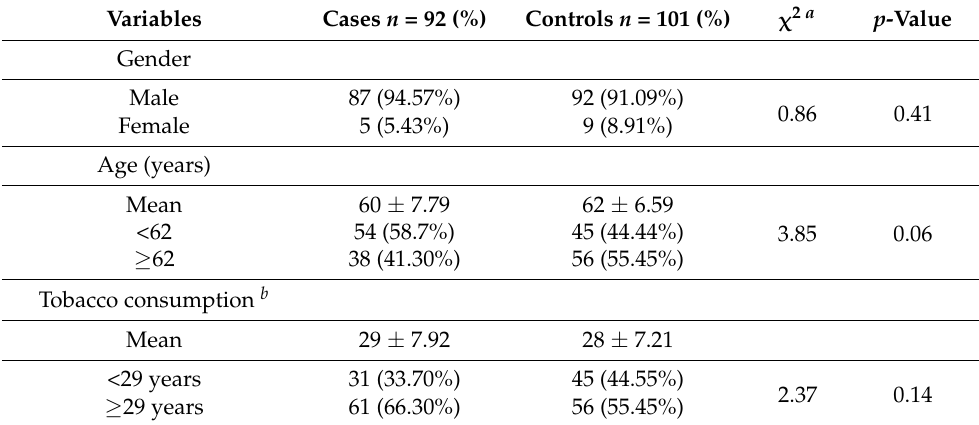
Table 2. Distribution of patients and controls according to demographic characteristics. Variables Cases n = 92 (%) Controls n = 101 (%) χ 2 a p -Value